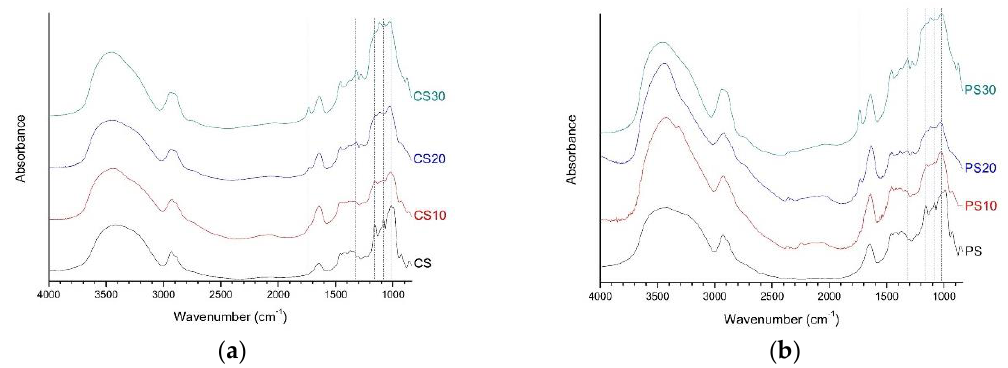
Figure 1. The FT-IR spectra of native starch and starch aldehydes: ( a ) corn starch series; ( b ) potato starch series.